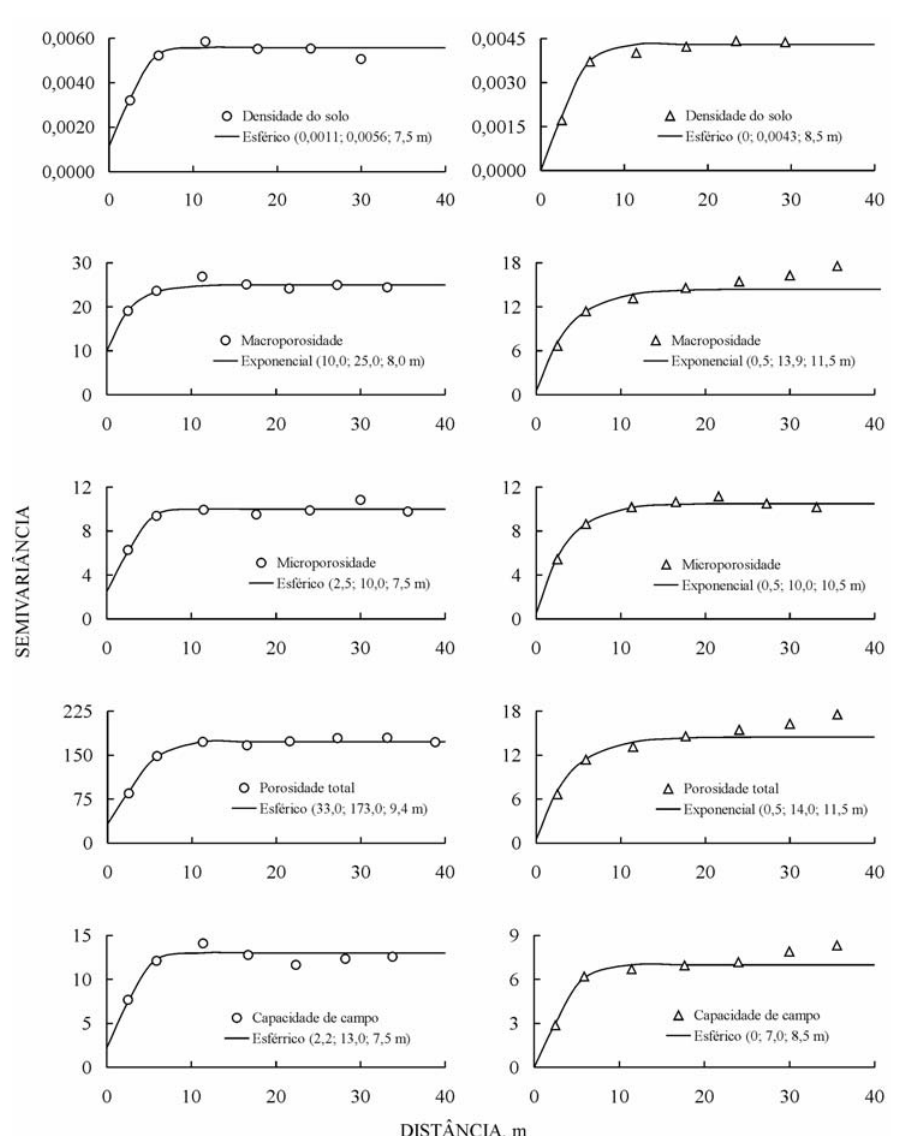
Figura 1. Semivariogramas experimentais simples e modelos matemáticos ajustados à densidade do solo, à macroporosidade, à microporosidade, à porosidade total e à capacidade de campo no plantio direto ( ) e no preparo convencional ( ). Os valores dentro dos parênteses correspondem, respectivamente, aos efeitos pepita, patamar e